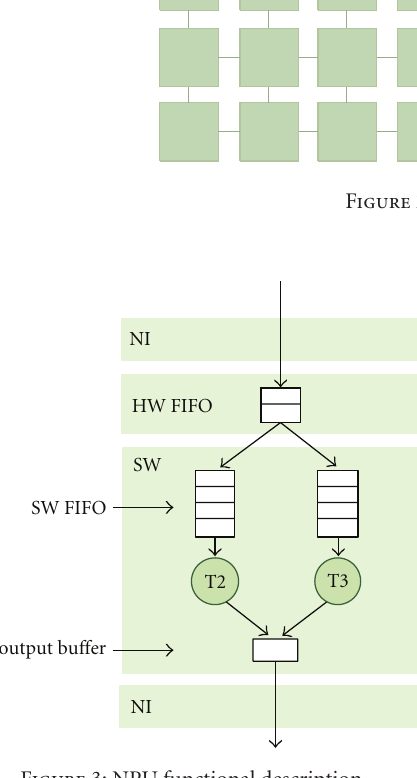
Figure 3: NPU functional description.